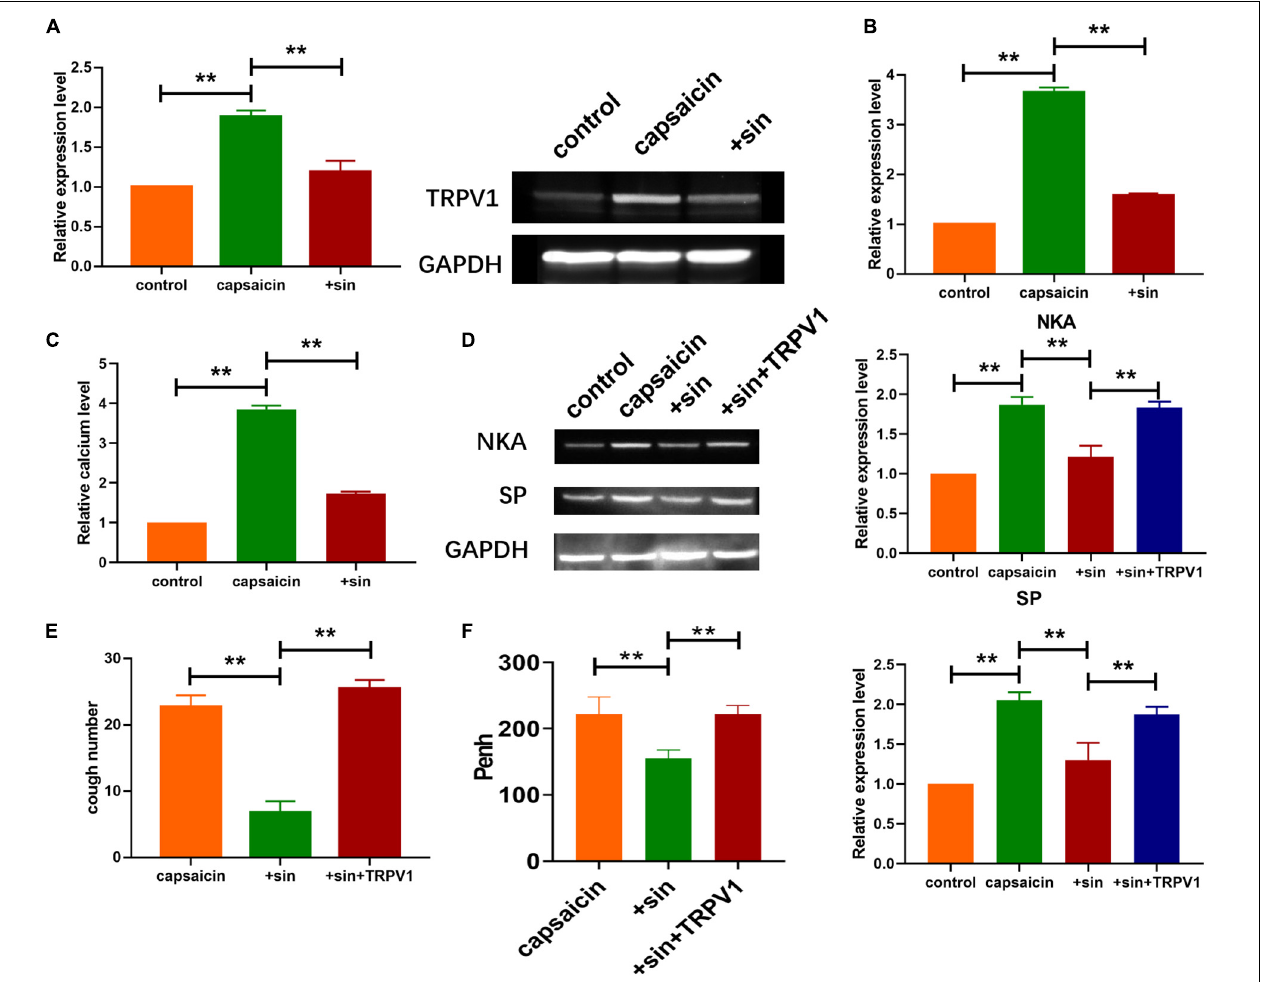
FIGURE 2 | Sinomenine inhibited the expression of TRPV1 induced by capsaicin in neuronal cell. (A) Expression level of TRPV1 in neuronal cells, as measured using western blot analysis. Data are mean ± SEM; one-way ANOVA was used for statistical analysis. (B) qRT-PCR analysis showing the mRNA level of TRPV1 in neuronal cells. Data are mean ± SEM; one-way ANOVA was used for statistical analysis. (C) Intracellular calcium levels. Sinomenine inhibited capsaicin-induced calcium uptake in neuronal cells. Data are mean ± SEM; one-way ANOVA was used for statistical analysis. (D) Protein expression levels of SP and NKA were reduced by sinomenine and elevated after TRPV1 overexpression in neuronal cells. (E) CRS levels showing that effect of sinomenine was inhibited after TRPV1 administration. Data are mean ± SEM; one-way ANOVA was used for statistical analysis. (F) Effect of TRPV1 administration on Penh. Data are mean ± SEM; one-way ANOVA was used for statistical analysis. ** P < 0.01; n =